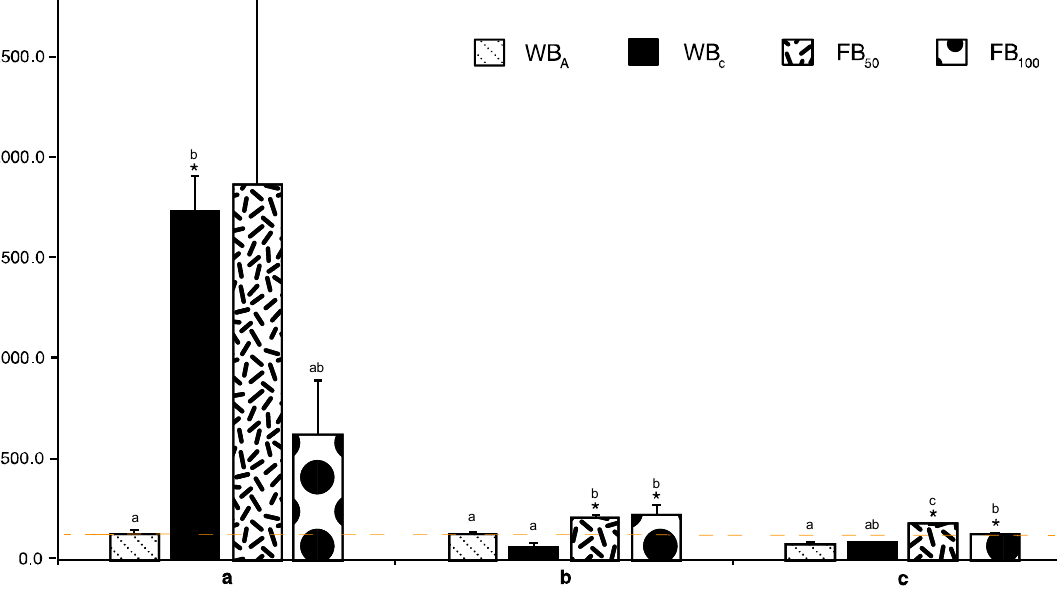
Figure 3. Effect of insect herbivory on flavonoid content in white cabbage. ( a ) Quercetin; ( b ) luteolin; ( c ) kaempferol. All bar values for experimental levels of compounds were recalculated relative to the content in untreated samples taken as 100% (dashed line). WB A , adult cabbage butterflies (egg laying and hatching larvae), WB C 2nd instar larvae, FB 50 fifty flea beetles per box, and FB 100 , one hundred flea beetles per box. Data are means of three repeats ± SE. The asterisk (*) represents a significant difference between treated samples and controls, and different letters between the values of one compound. p < 0.05 by Fisher’s least significant difference (LSD) test.